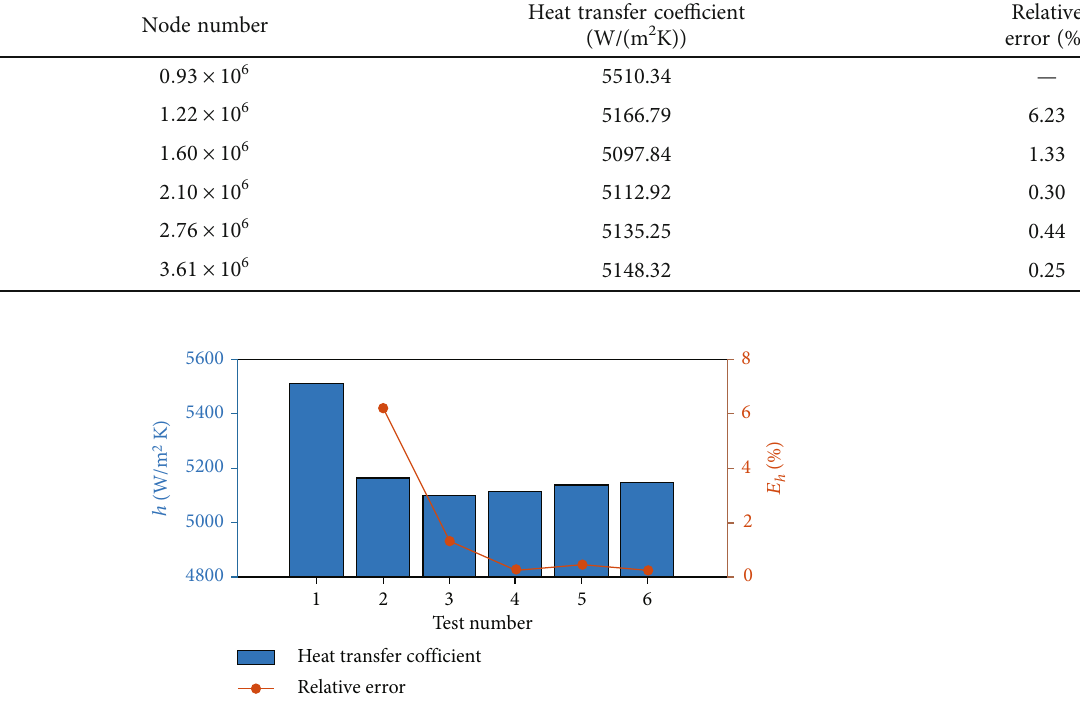
Figure 9: The results of the grid-independent test. Table 2: Material properties of GH4169.